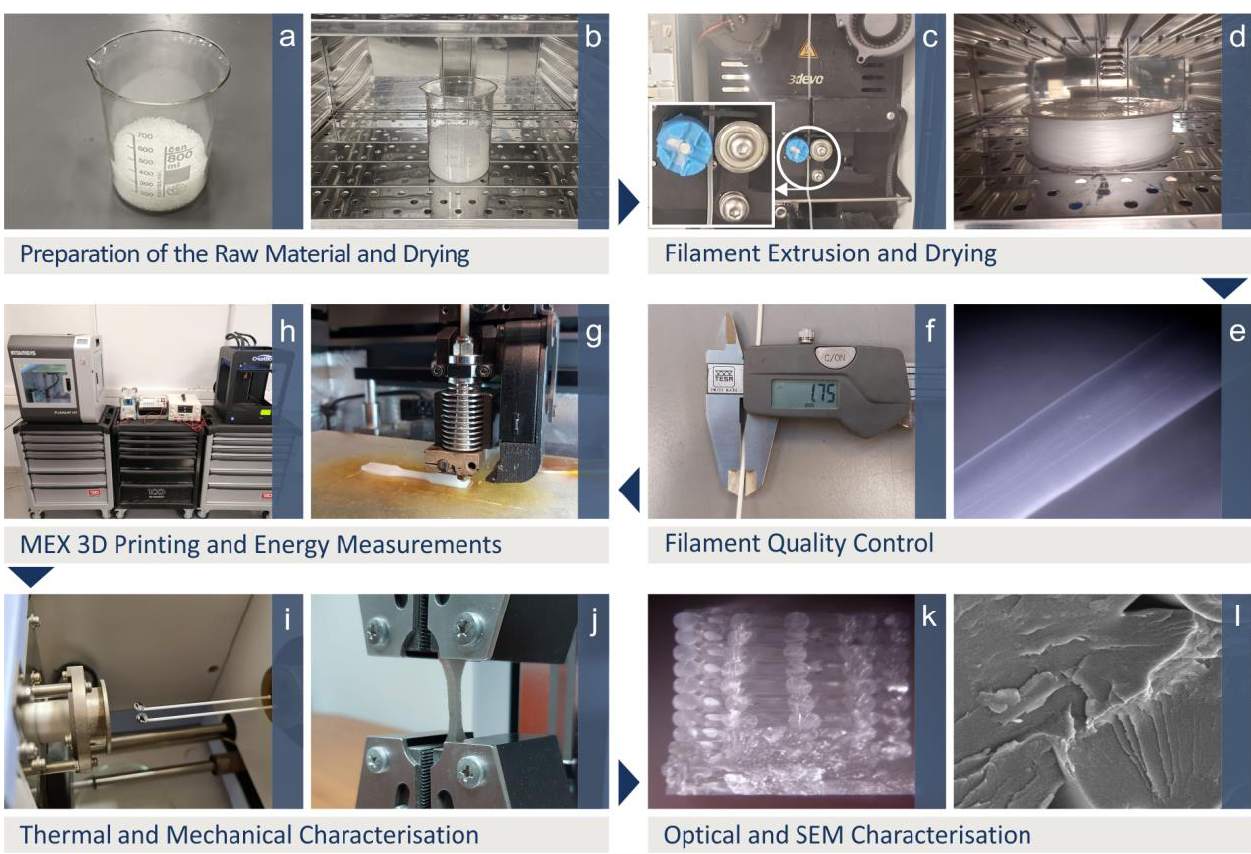
Figure 1. Experimental process. ( a ) PMMA in powder form, ( b ) drying of the PMMA powder, ( c ) PMMA filament extrusion, ( d ) PMMA filament drying, ( e , f ) filament quality control, ( g ) samples MEX 3D printing, ( h ) energy measurements, ( i ) thermal-properties determination, ( j ) mechanical testing, and ( k , l ) morphological characterization.